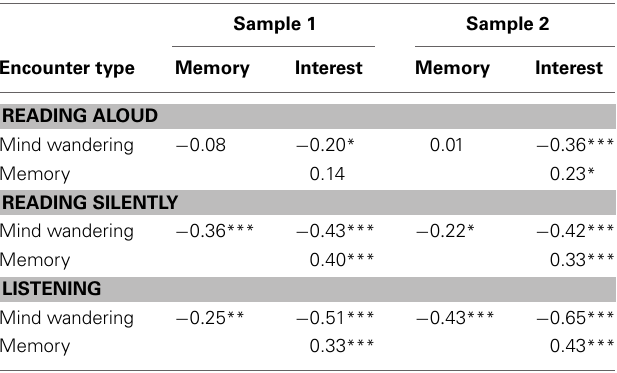
Table 1 | Pearson product-moment correlations of Proportion of Mind Wandering (Mind Wandering), Memory Test Proportion Correct (Memory) and Interest Rating (Interest), for each Encounter Type and